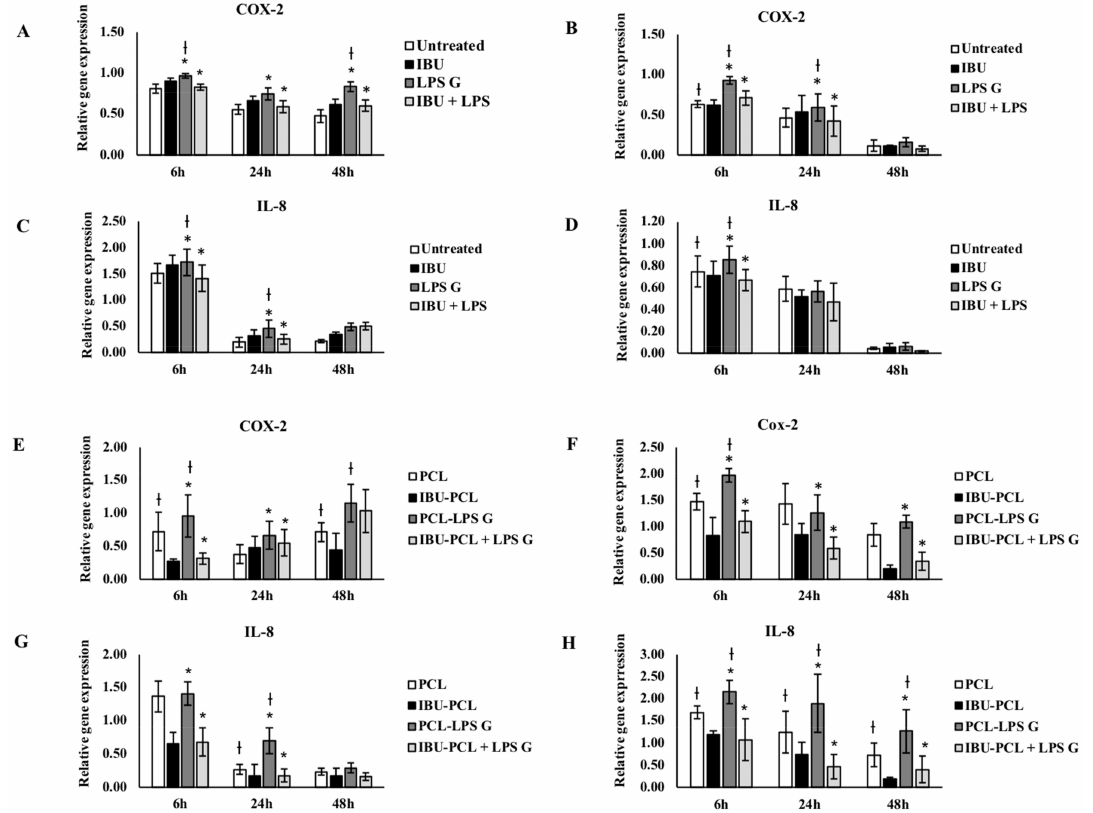
Figure 3. Gene expression of COX-2, IL-8 in EC ( A , C , E , G ) and FB ( B , D , F , H ) cultured on plastic ( A – D ) and PCL membrane ( E – H ). Relative mRNA levels were analyzed by real-time RT-qPCR for COX-2, IL-8 in EC and FB after 6 h and 24 h. Data are expressed as mean ± SD. † Difference between non-stimulated and stimulated cells, p < 0.05; * difference between stimulated cells with or without IBU, p <